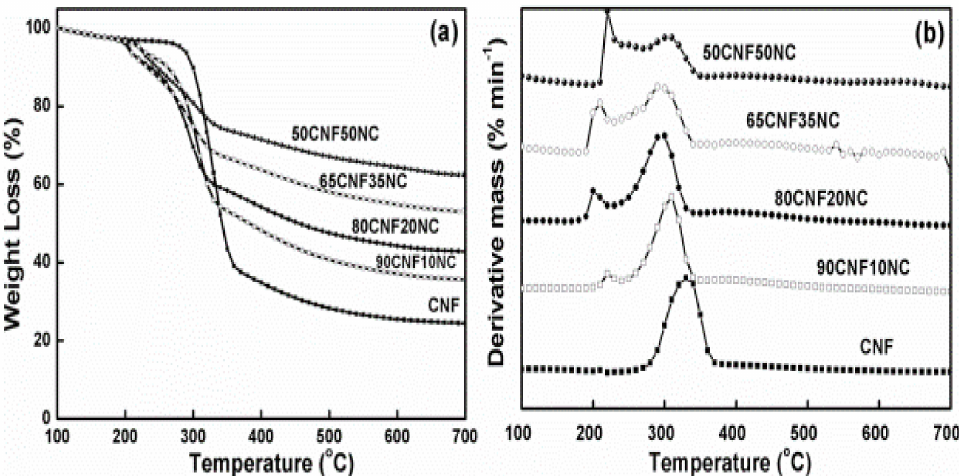
Figure 8. TG ( a ) and DTG ( b ) curves of CNFs / NC composites at a heating rate of 10 ◦ C / min.